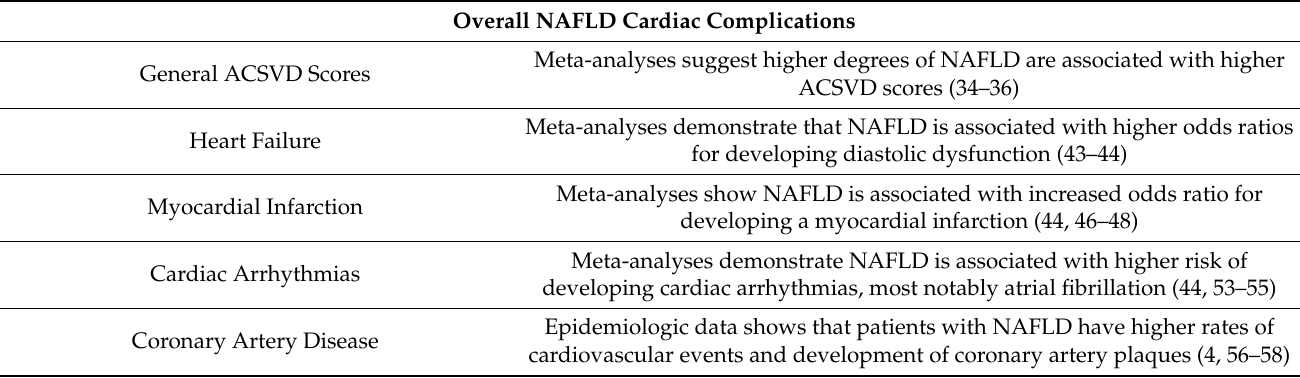
Table 1. Overall NAFLD cardiac